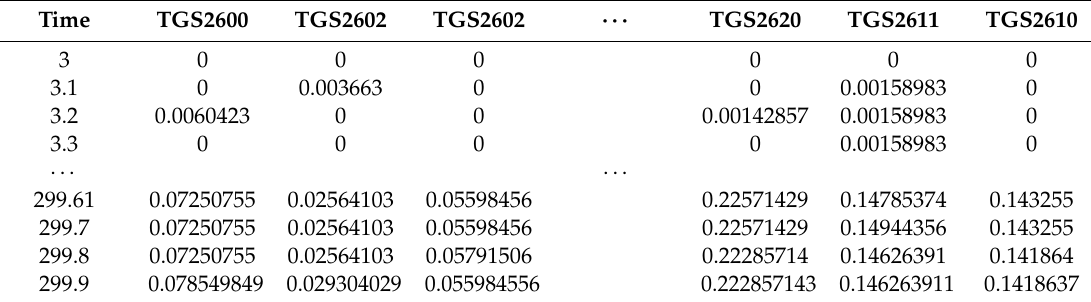
Table 5. The standardized